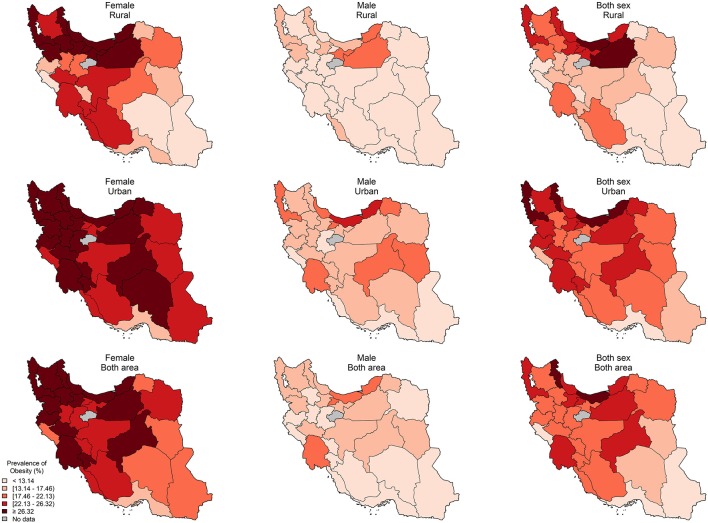
The provincial distribution of age-standardized prevalence of obesity (%) by residential area and sex.